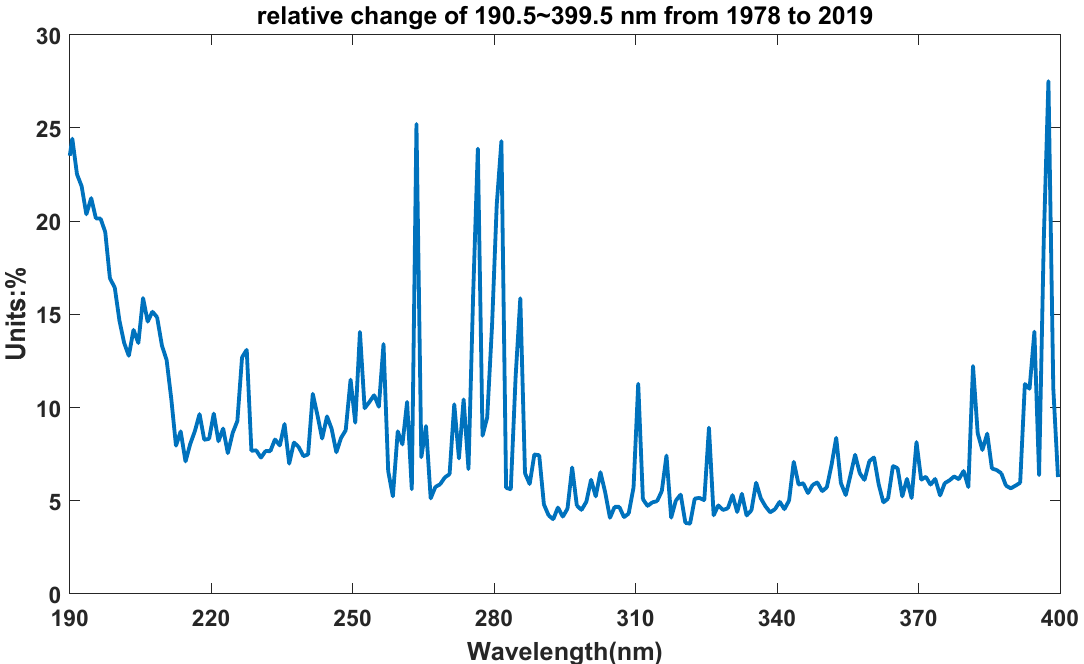
Figure 1. Flare irradiance changes at various wavelengths from 190.5 nm to 399.5 nm in the GSFC Composite Solar Spectral Irradiance data from 8 November 1978 through 21 November 2019.